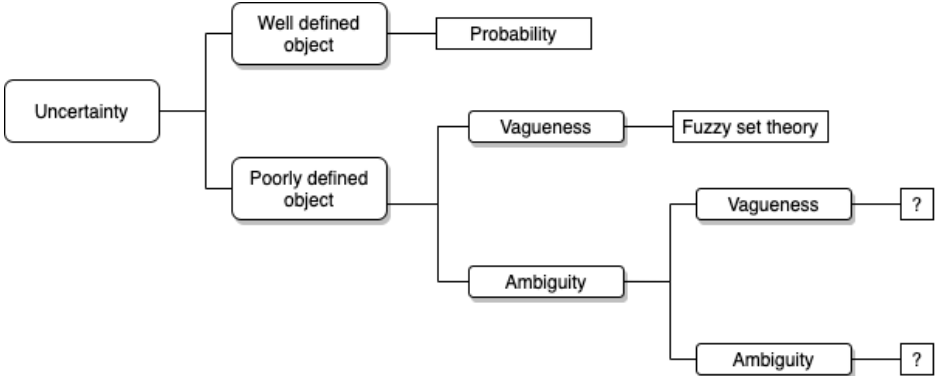
Figure 1. Fisher et al.’s taxonomy of uncertainty. Our work focuses on categories of poorly defined objects